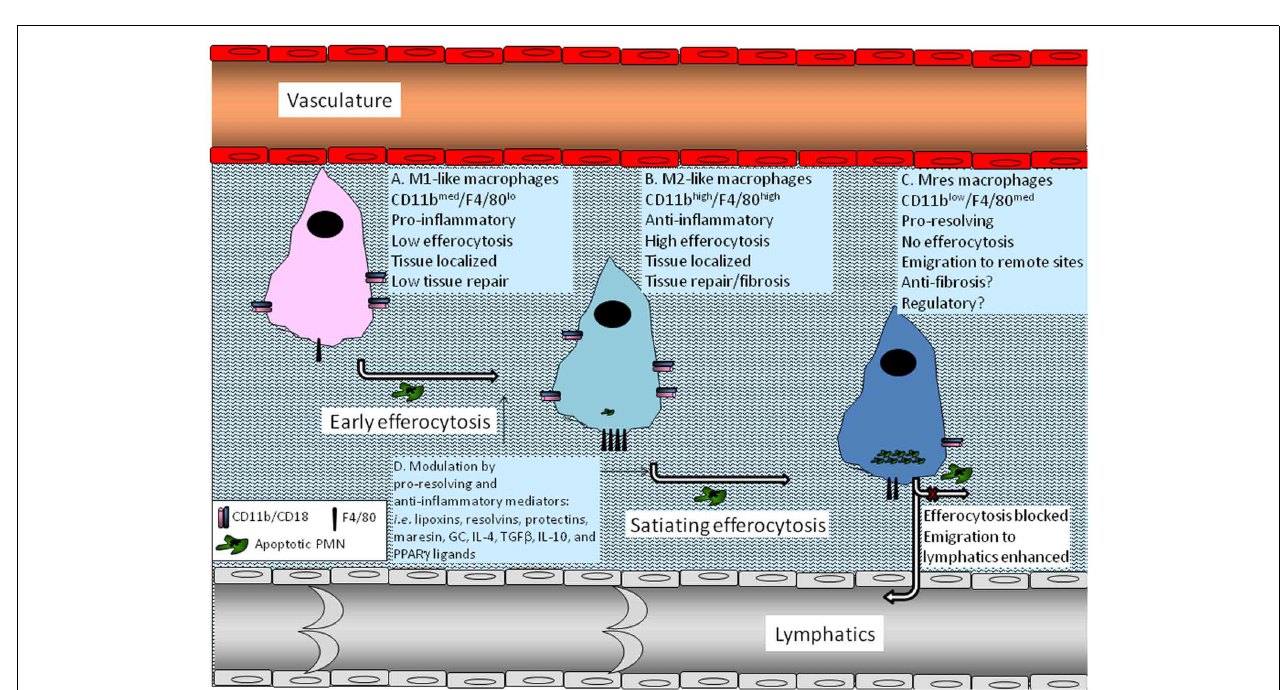
FIGURE 1 | Macrophage phenotype conversions induced by efferocytosis. A monocyte that infiltrated an inflamed tissue differentiates to a macrophage and adopts an M1-like phenotype previous to encounter with apoptotic PMNs (A) . Once it encounters apoptotic PMN and starts to